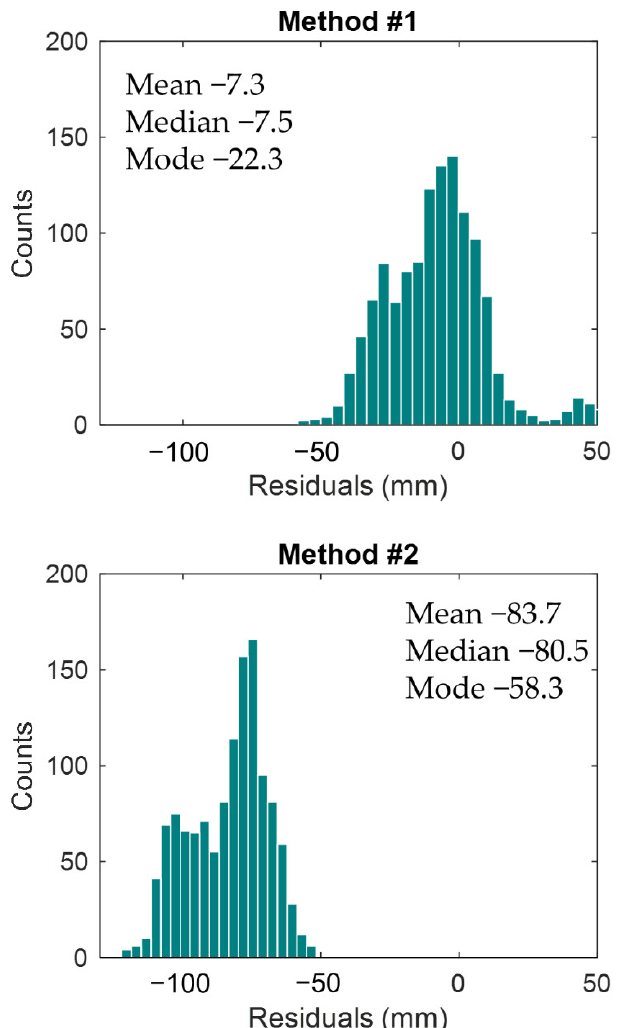
Figure 10. Histogram of the residuals between the ZTD derived from models (upper for Method #1 and lower for Method #2) and the reference ZTD.